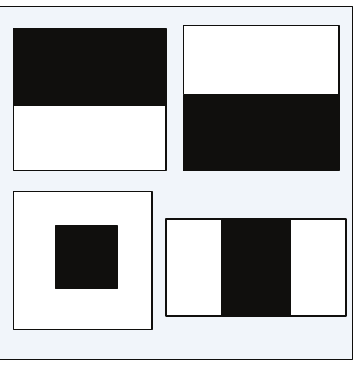
Figure 1: Rectangular